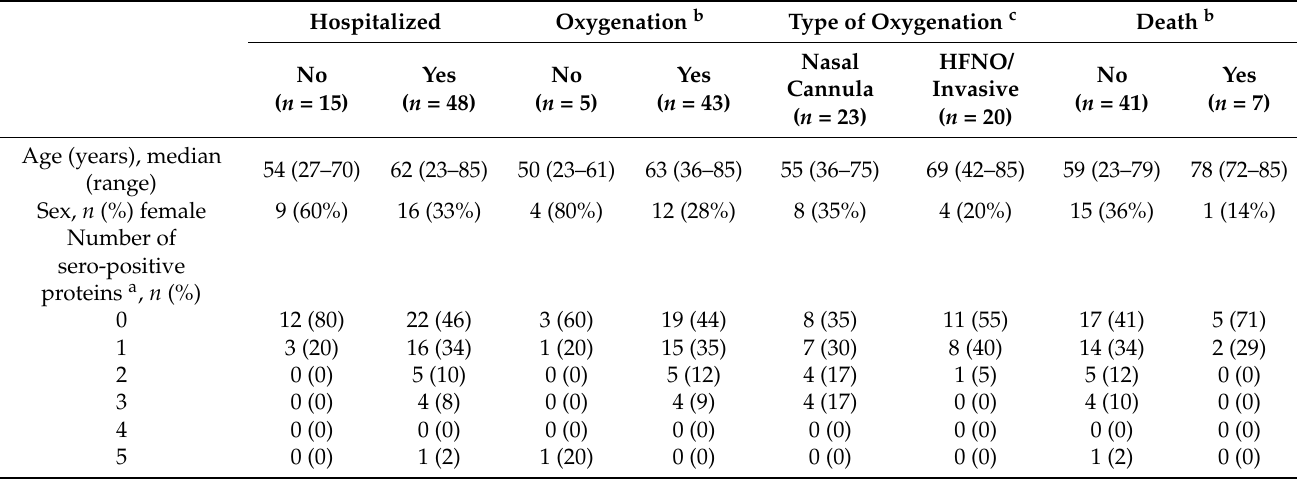
HFNO, High-Flow Nasal Oxygen; a among all proteins except N, N-EP3, S1, S1-RBD, S2, and S2 (cid:48) ; b among hospitalized patients; c among those patients that needed oxygenation. All percentages were